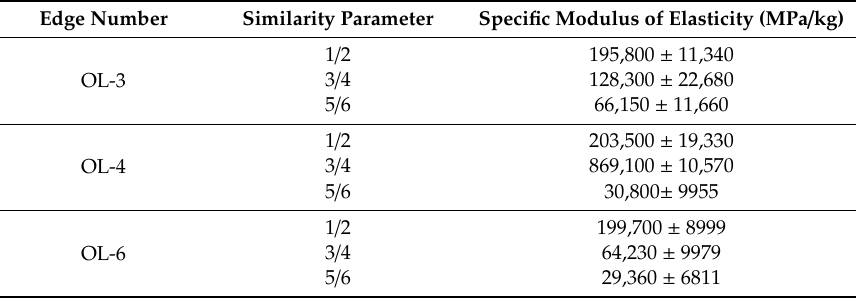
Table 3. Specific modulus of elasticity.